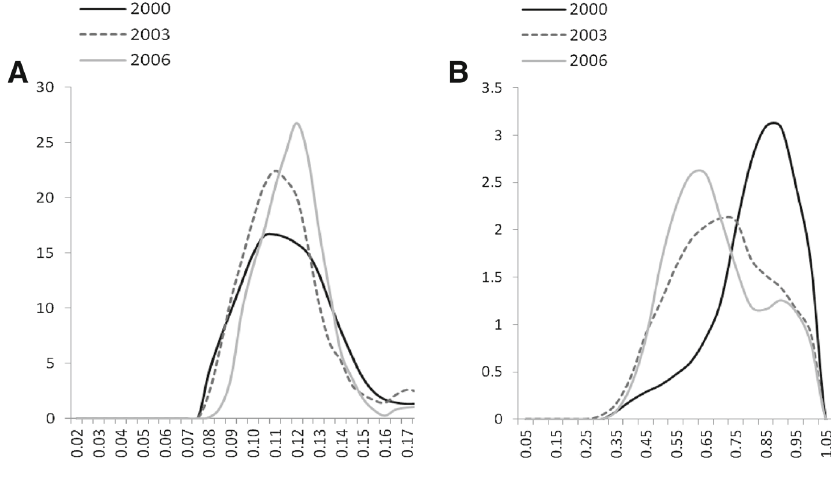
Fig. 2 Distribution of capital ratios of Spanish banks, selected years reserves, and preferred shares (up to a maximum), and Tier II comprised the rest of the hybrid instruments. During the sample period, banks had to keep a minimum of 4% of their risk-weighted assets in the form of Tier I and 8% in Tier I+Tier